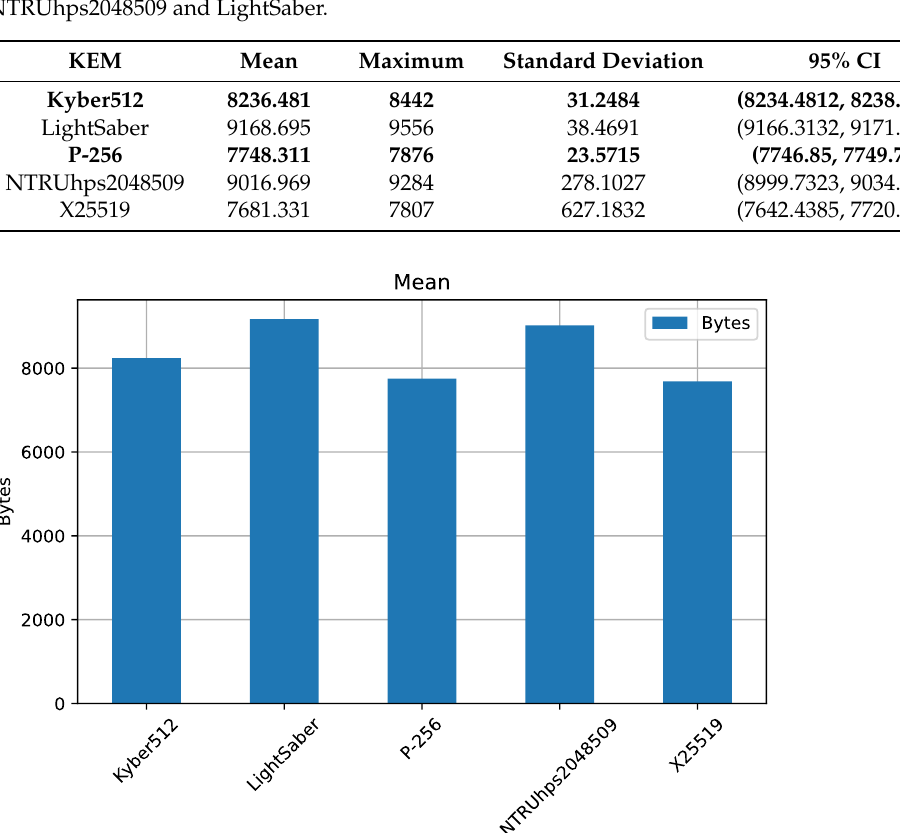
Figure 8. Number of packets transmitted during the connection. The elliptic curves performed better than the post-quantum KEMs. Kyber512 still performs better, followed by NTRUhps2048509 and LightSaber. In Table 9, we show the 95% CI for the packet